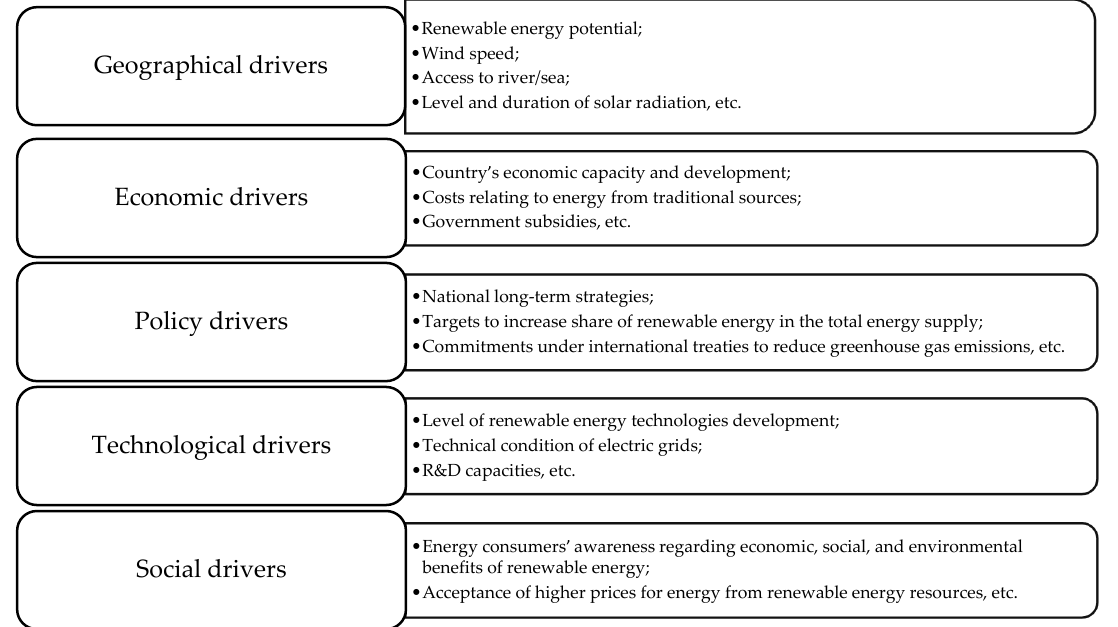
Figure 1. Driving forces of renewable energy increase in the overall energy supply. Source: authors’ elaboration on work by Xu et al. [3] and Shivakumar et al. [4].